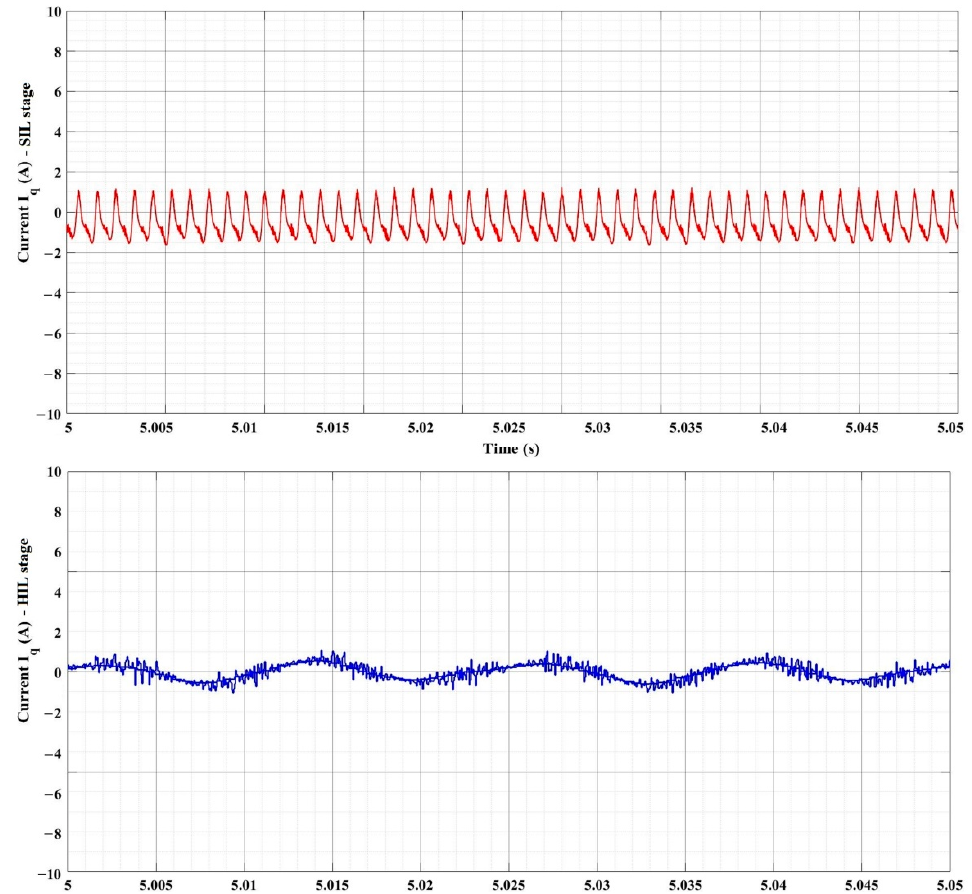
Figure 42. Comparison of i q current evolution in the numerical simulation (SIL stage) and in real-time (HIL stage).